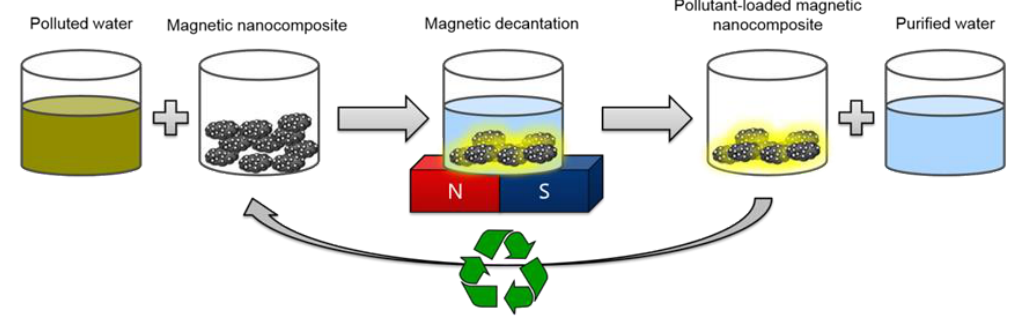
Figure 1. Schematic representation of the preparation and use of magnetic nanocomposites for water purification.